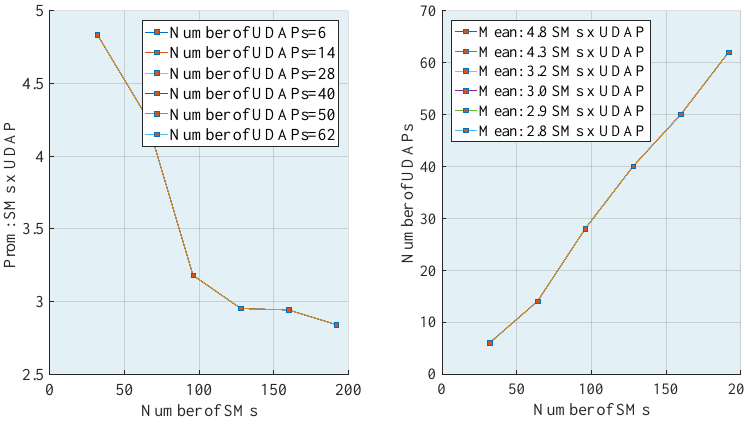
Figure 8. Chargeability of SMs and number of UDAPs.